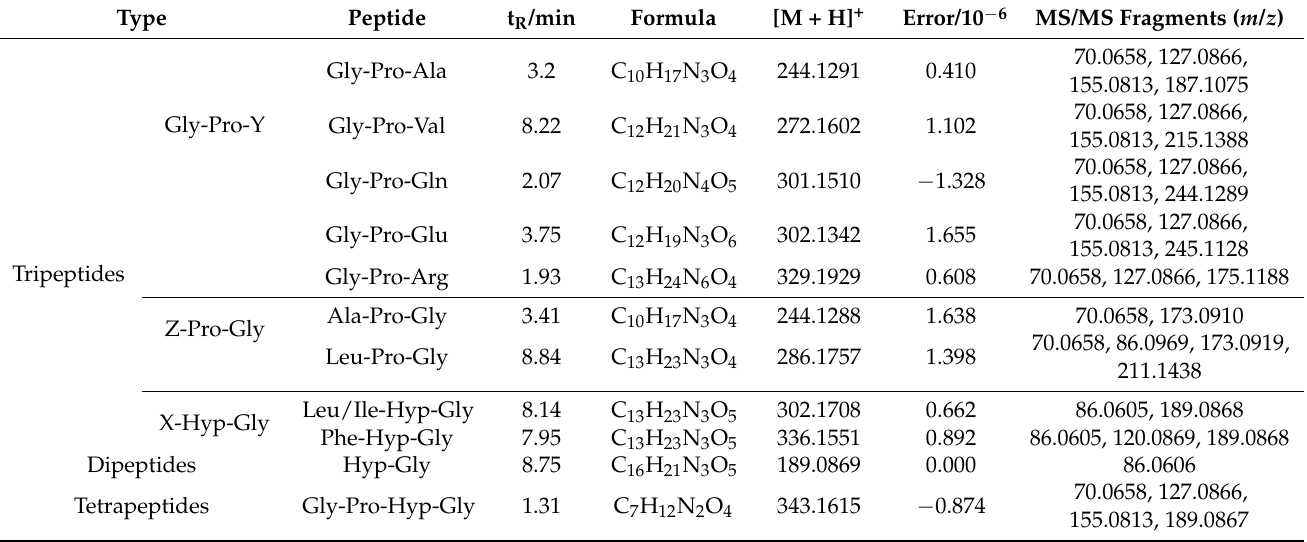
Table 3. The dipeptides and tripeptides in the GDCH.